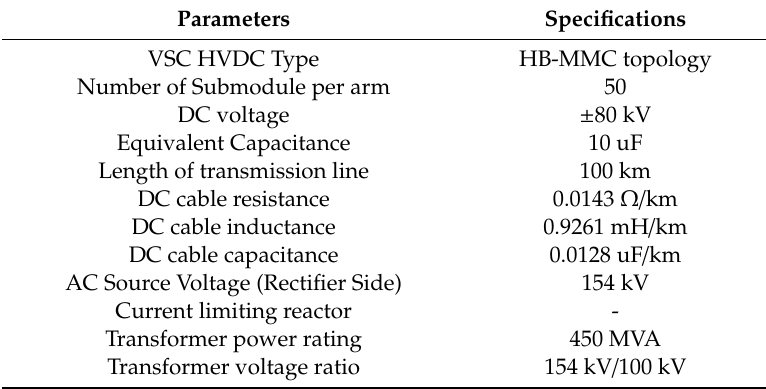
Table 1. Parameters of HB-MMC HVDC